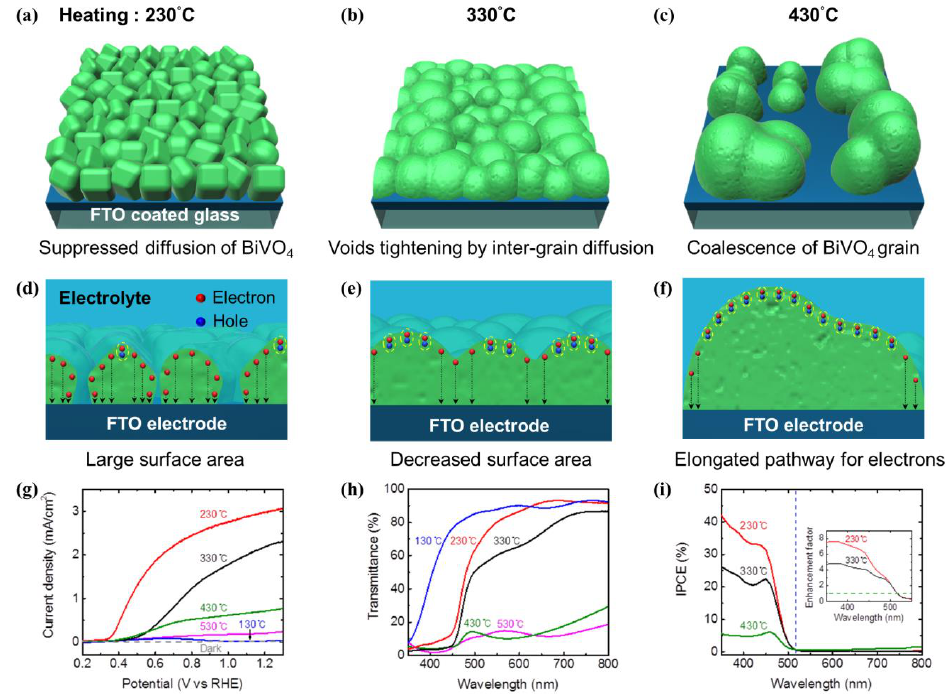
Figure 4. Schematic representation of surface area-controlled BiVO 4 film deposited by pulsed laser deposition. Microstructural changes and charge collection abilities of BiVO 4 film deposited at ( a , d ) 230 °C, ( b , e ) 330 °C, ( c , f ) 430 °C. ( g ) PEC performances, ( h ) UV-vis transmission spectra, and ( i ) incident photon-to-current efficiency (IPCE) of the samples. Reprinted with permission from [10]. Copyright 2017, American Chemical Society.